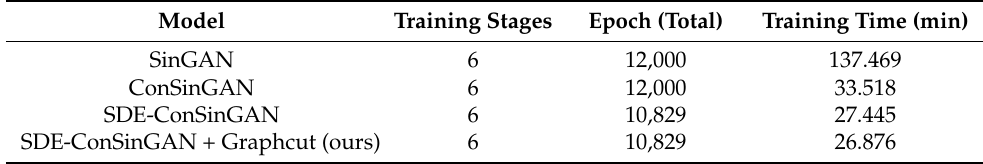
Table 4. Time comparison of different image-generation